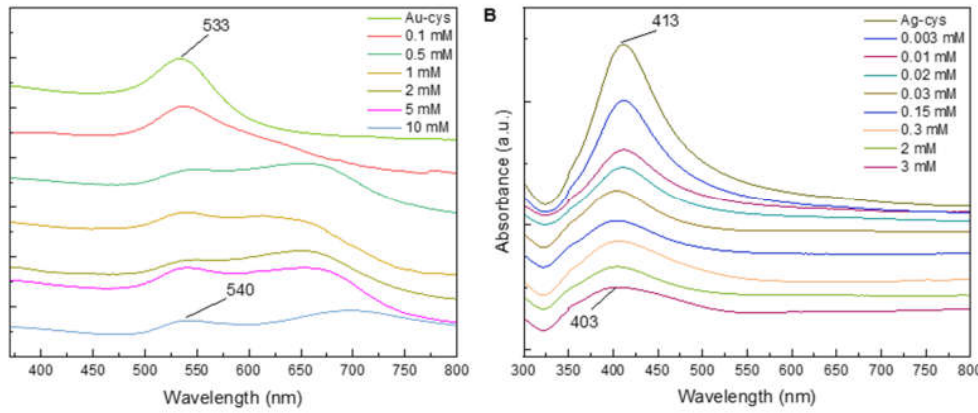
Figure 4. UV–Vis absorption spectra after the addition of different concentration of glyphosate for: ( A ) Au NPs and ( B ) Ag NPs. SERS Detection of Glyphosate in Colorimetric Assay After the colorimetric measurements, the SERS signal of different glyphosate concen- trations was determined for gold or silver NPs modified with cysteamine. Figure 5 shows the SERS spectra of the corresponding glyphosate concentrations for 532, 632 and 785 nm laser excitations. As the analyte concentration decreases, the intensity of the glyphosate band at about 1030 cm −1 also decreases. Some other bands are also present in the spectra (e.g., the band at 917 cm −1 when excited with 632 nm, or at 1002 cm −1 when excited at with 532 nm), but their intensity does not change with concentration, and they cannot be said to originate from glyphosate (or cysteamine). Using NPs modified with cysteamine, good glyphosate bands at ≈1030 cm −1 were obtained with Ag NPs and excitation at 532 nm and with Au NPs and excitations at 632 and 785 nm. This peak is present in all spectra, and its intensity decreases with decreasing concentration. There- fore, it can be used as a glyphosate indicator, and according to the SERS data, the cysteamine- modified colorimetric assay increases the detection limit to 10 µM in all three cases.